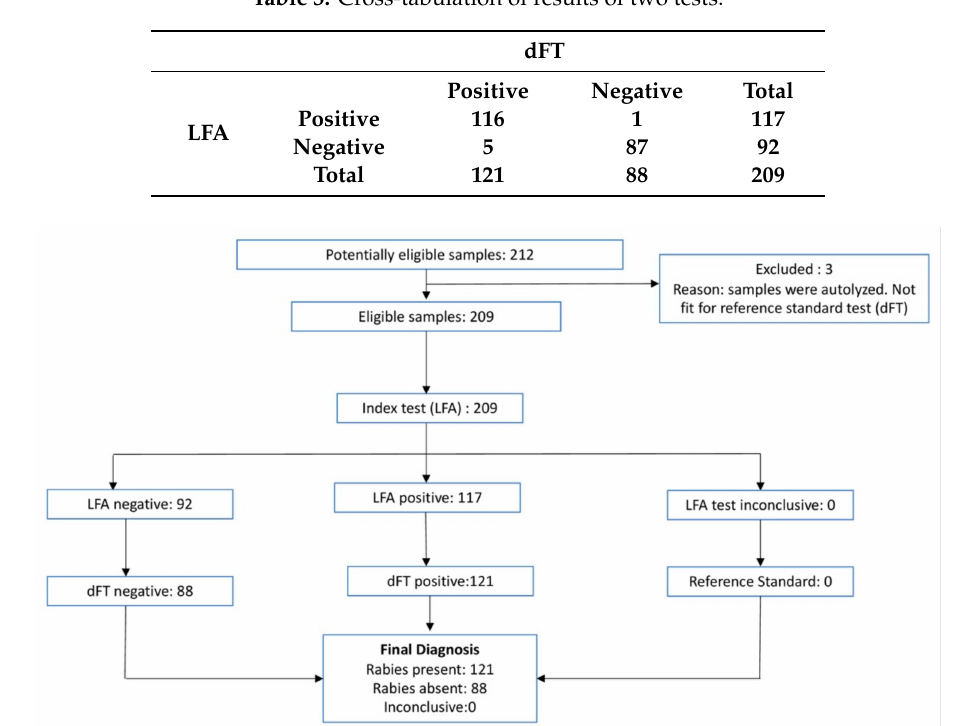
Figure 2. Flowchart showing test results of LFA and direct fluorescence antibody test